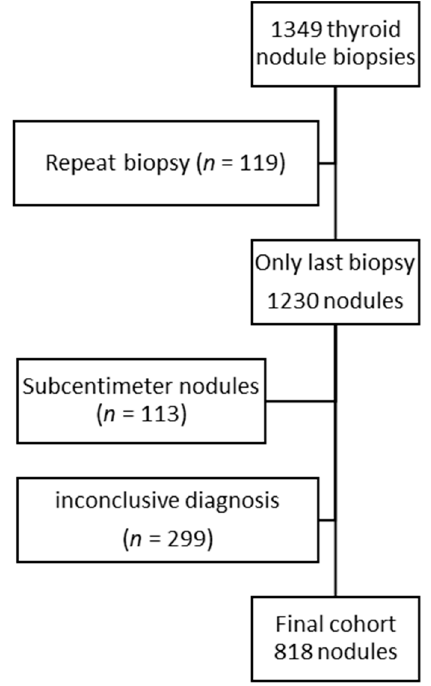
Figure 1. Flow chart of included nodules. The age distribution of the final cohort (median 56 years, interquartile range 46 – 66 years) was not significantly different from the age distribution of the excluded nodules (median 56 years, interquartile range 46 – 67 years; p = 0.75).